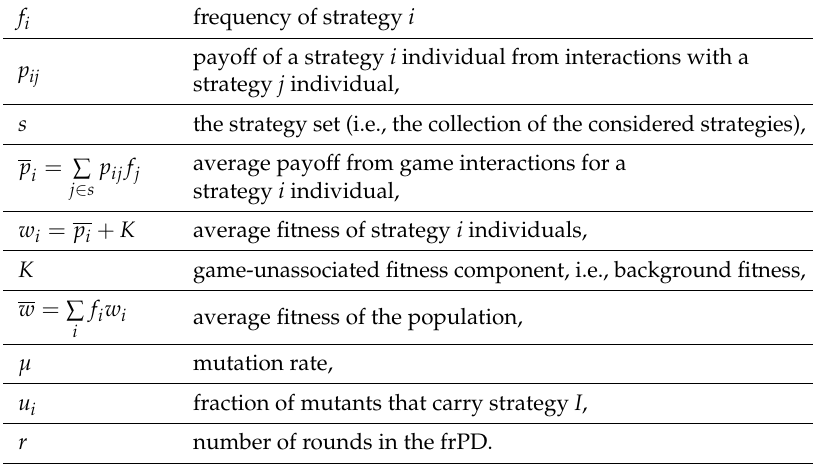
Table 1. Overview of parameters in the